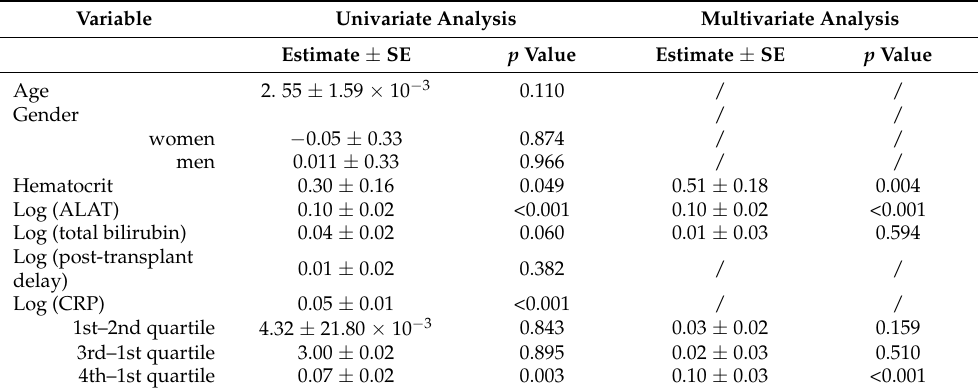
Table 2. Univariate and multivariate linear mixed-effect regression analyses for the identification of the determinants of log tacrolimus trough concentrations adjusted for dose ( n = 1573) during longitudinal therapeutic drug monitoring.